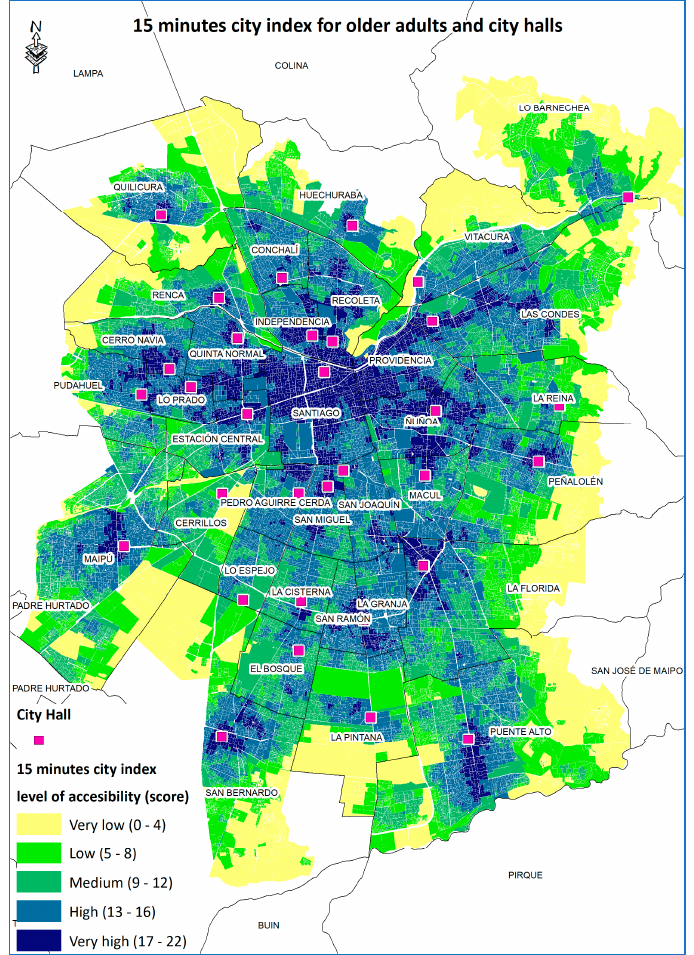
Figure 4. Spatial distribution of the 15-min city accessibility index and location of the municipalities.